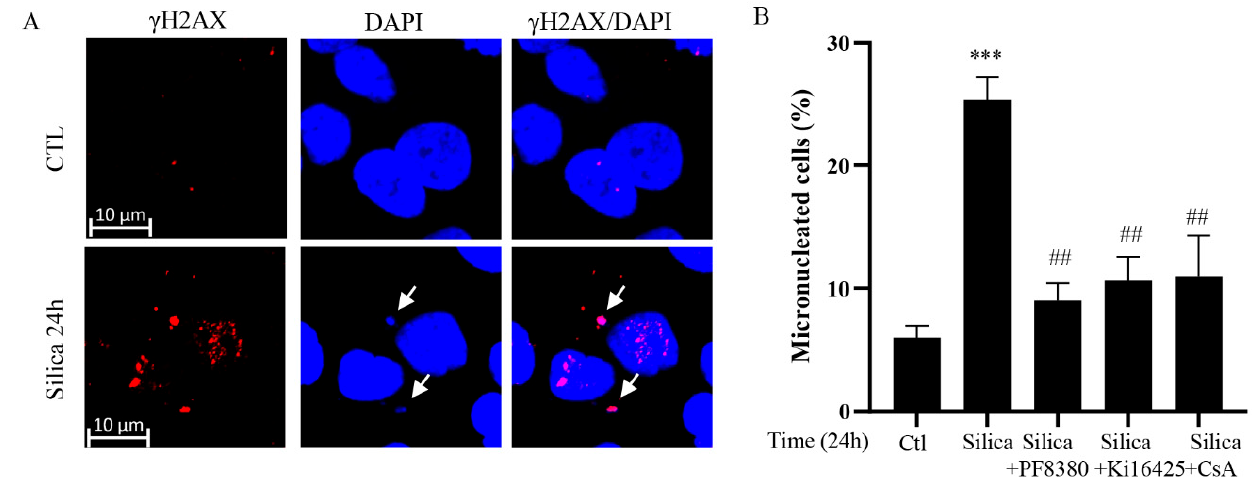
Figure 7. Silica-induced micronuclei formation in 16HBE cells. In ( A ), representative confocal images showing γ H2AX (red) and nuclear (blue) staining in 16HBE cells exposed to silica (5 µ g/cm 2 ) for 24 h. ( B ) 16HBE cells pretreated with PF8380, Ki16425, or CsA for 1 h and then exposed to silica (5 µ g/cm 2 ) for 24 h. The number of micro-nucleated cells (%) was analyzed employing confocal microscopy. Bars show means ± SD. All experiments were performed at least in triplicate. *** p < 0.001 compared to control. ## p < 0.01 compared to silica exposure, as determined by ANOVA.